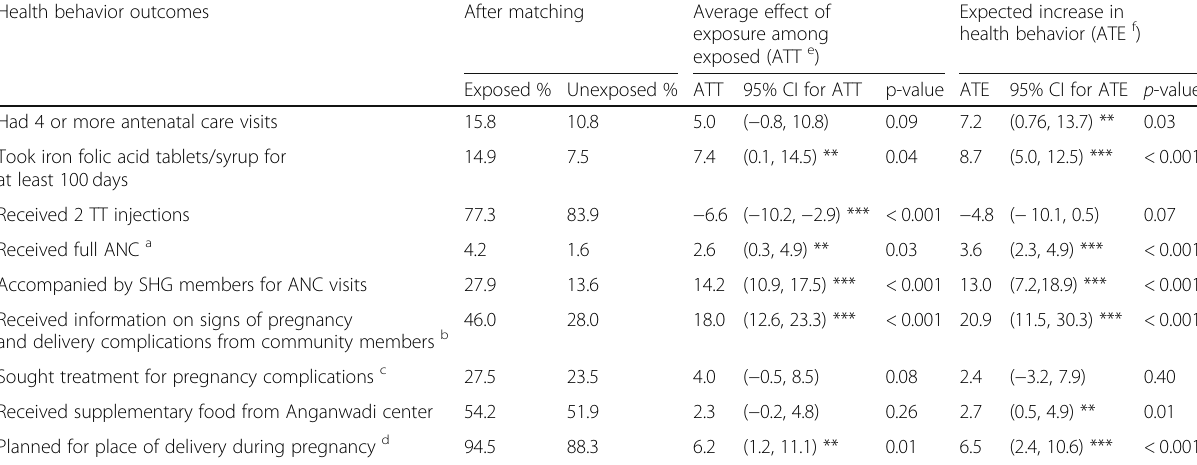
Table 3 Estimated impact of exposure to health interventions on antenatal care-related outcomes among self-help group women, Bihar, India, 2016 Health behavior